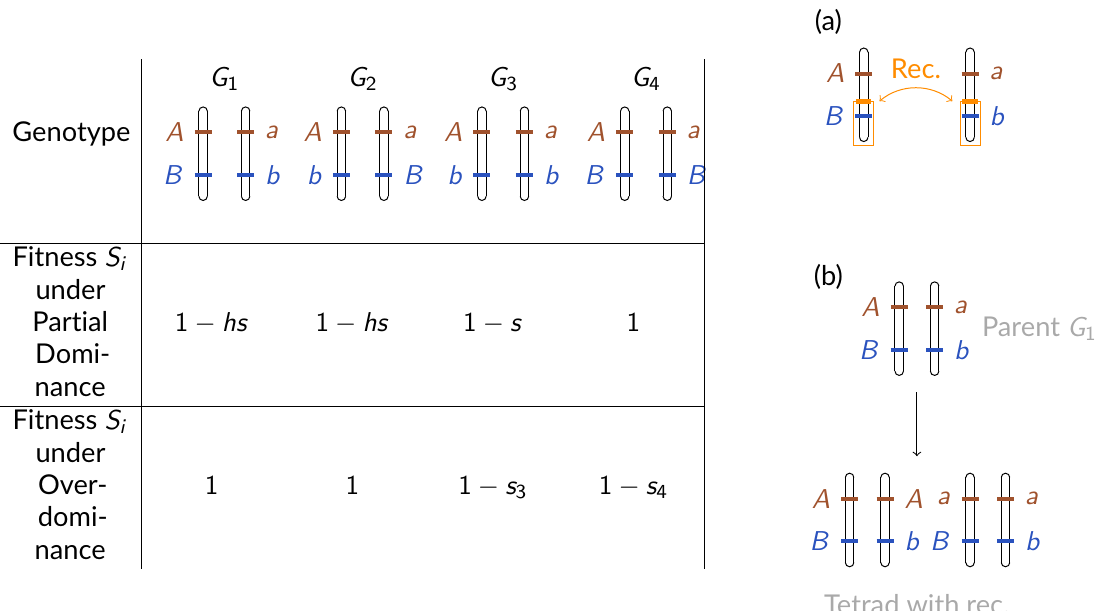
Figure 1 – Schematic drawings of the genotypes considered and their parameters. (Left) Description of the possible genotypes in the population and their fitness S i for the two selection scenarii considered (partial dominance and overdominance). (Right) (a) Position of a putative event of recombination between the mating-type locus and the load